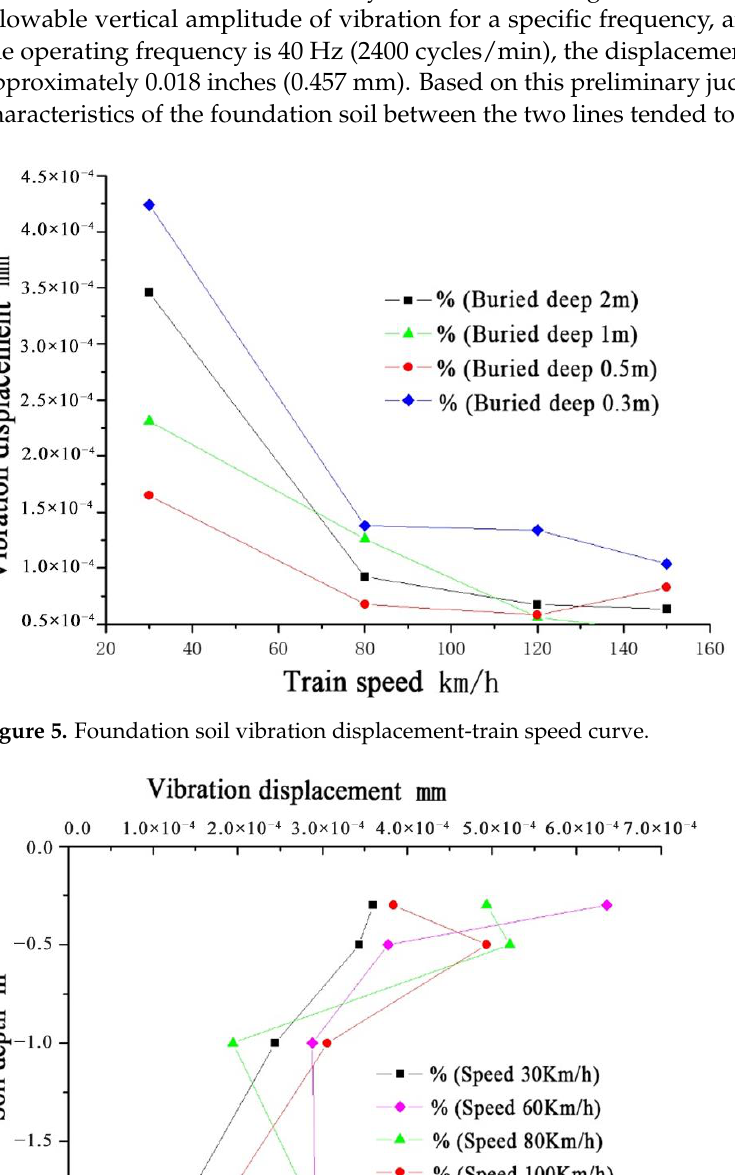
Figure 7. The vibration displacement peak trend of different construction stage vibrations.